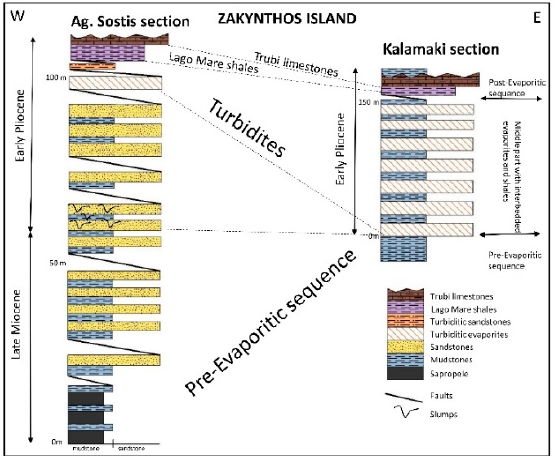
Figure 2. Synthetic stratigraphic column of the studied deposits, modified from [24,25], showing the two studied sections of Ag. Sostis and Kalamaki. With blue stars in Kalamaki section the places from where the Early Pliocene age was determined [24] were marked.